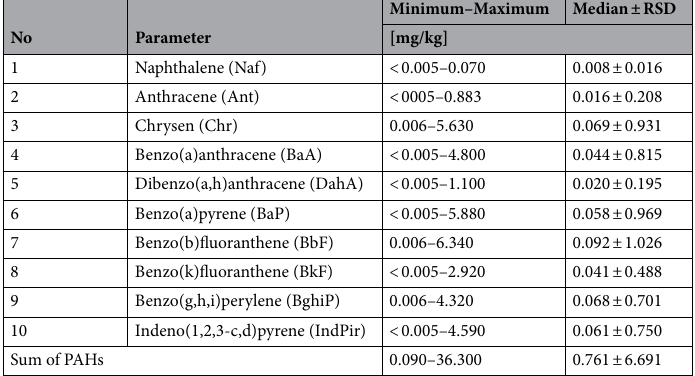
Table 3. The content of individual PAHs and their sum in samples (Me and RDS for n = 39).